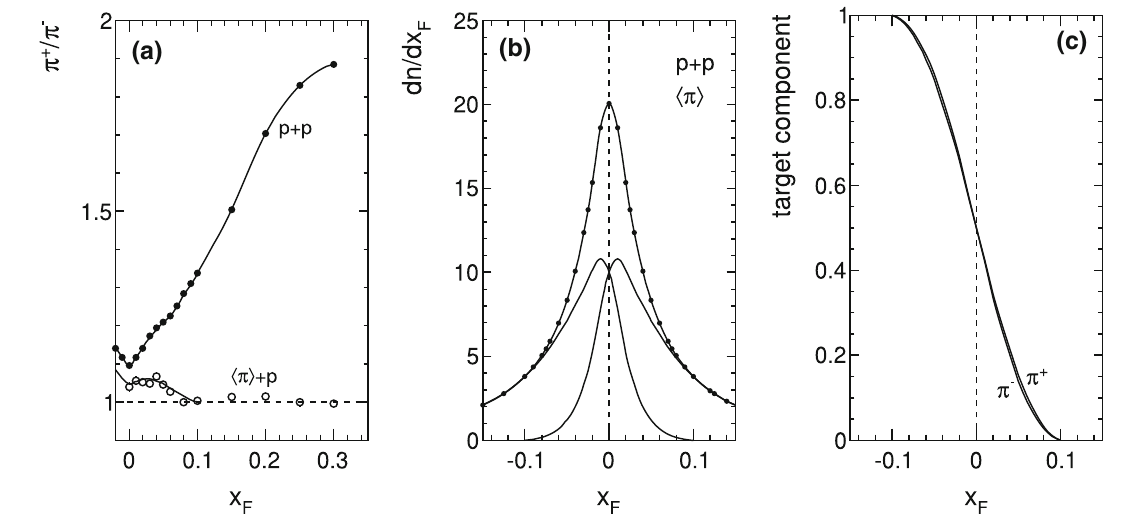
Fig. 131 a π + / π − ratioinp+pand (cid:4) π (cid:5) +pcollisions; b targetandprojectilecomponentsofcharge-averagedpionproductionand c targetcomponent with respect to the total yield of π + and π − in p+p interactions Fig. 132 p T integrated π + / π − ratio as a function of x F in p+p and p+C: a without p T cut off and b with p T cut off included as the data points in p+p collisions are plotted only up to x F = 0.02. The data points concerned by an extrapolation of the low p T region are given as open